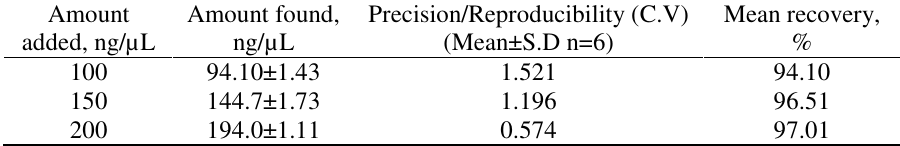
Table 2. Precision and accuracy of the method applied to spiked rutin samples Amount added,